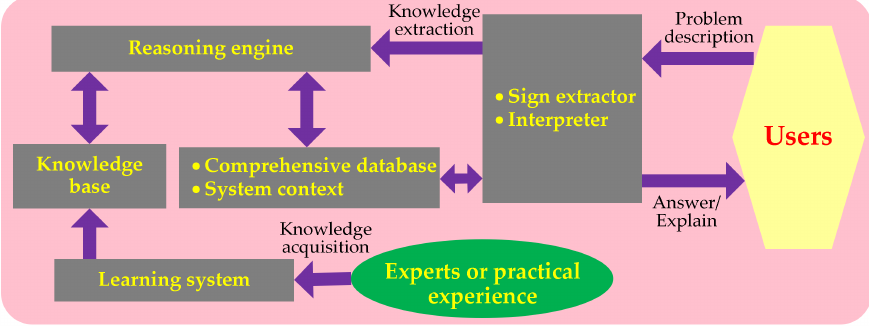
Figure 1. The interrelationship of each component in the